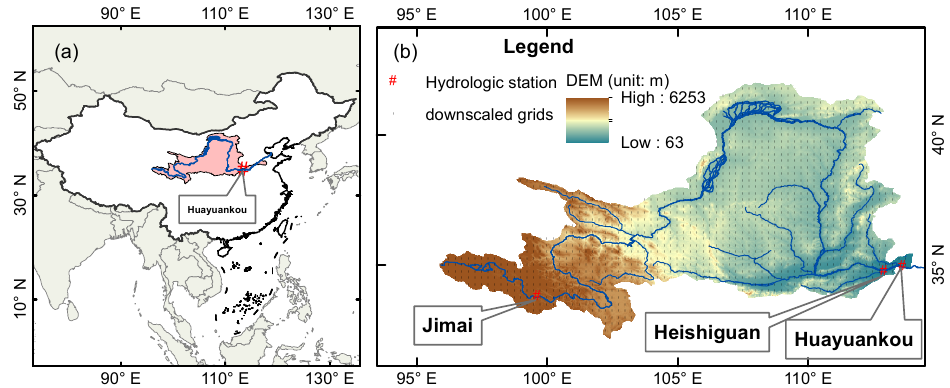
Figure 1. Location of ( a ) the Yellow River Basin and ( b ) three hydrological stations, together with basin topography and the grid of the downscaled climate dataset used in this